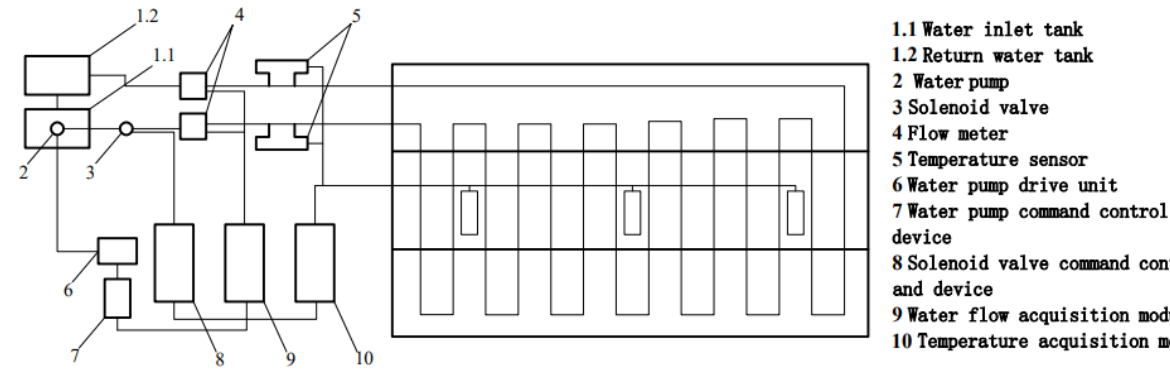
Figure 13. Structure diagram of the experimental system.